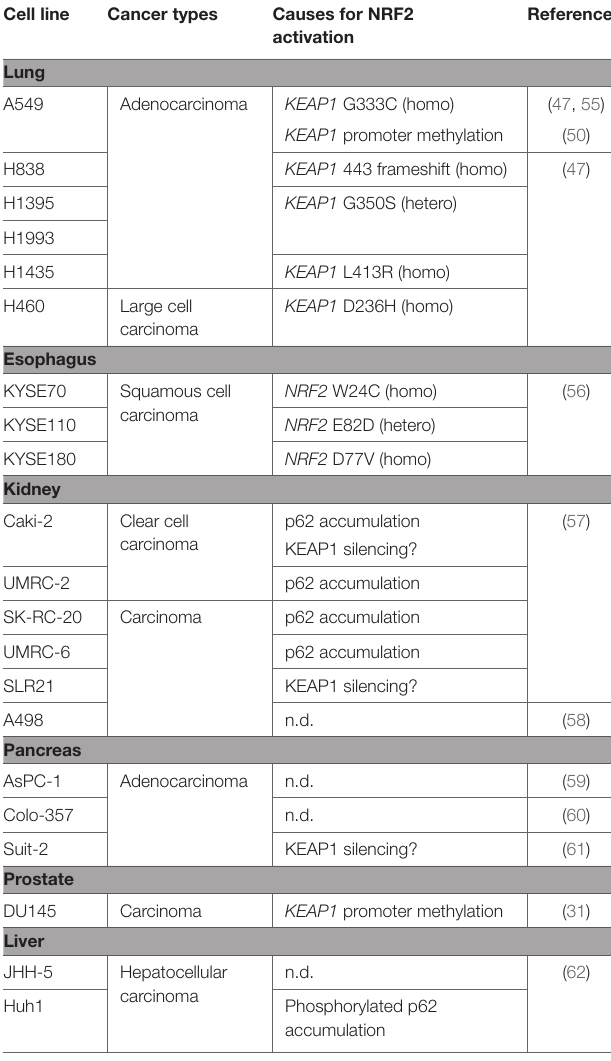
TABLe 1 | NRF2-addicted cancer cell lines. Cell